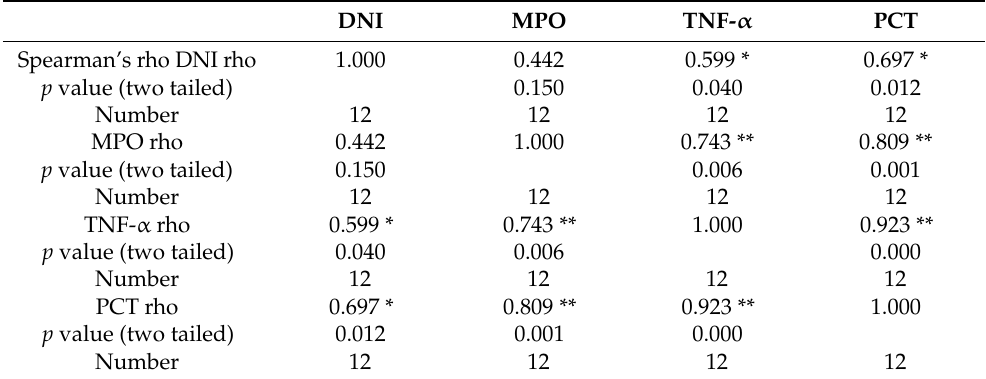
Table 4. Spearman’s rank correlation between sepsis biomarkers such as DNI, MPO, TNF- α , and